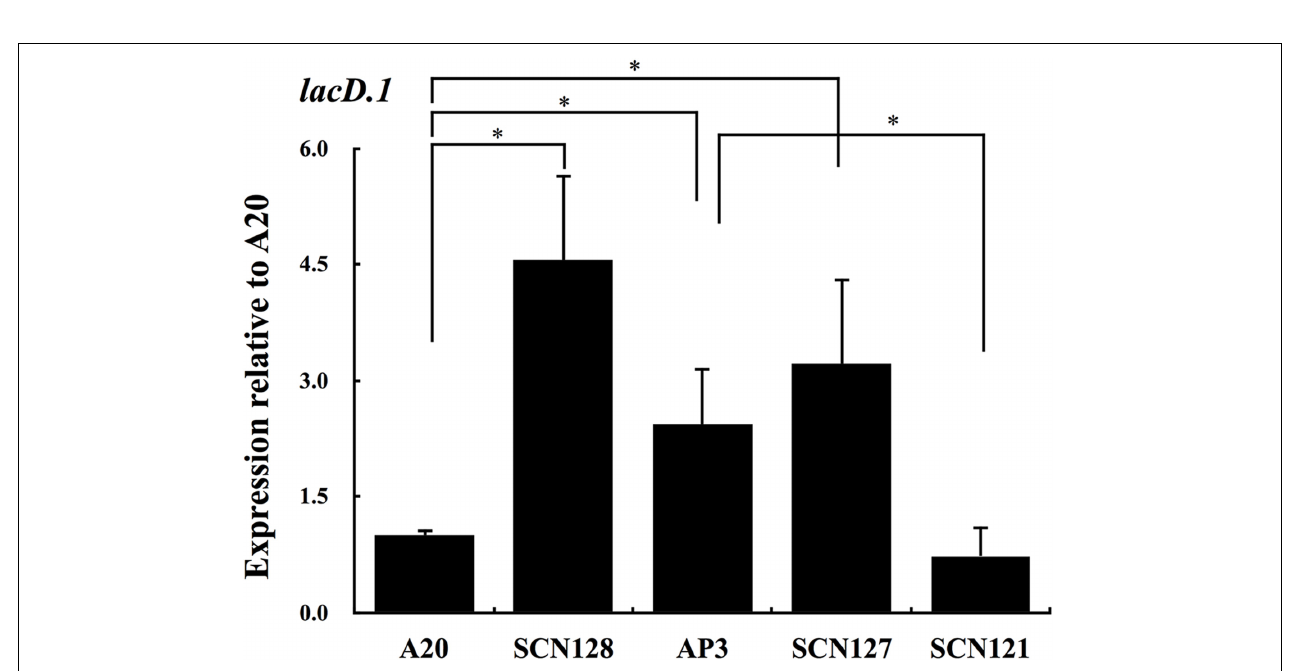
FIGURE 5 | The expression of lacD.1 in wild type A20 strain, A20 CovR D53A mutation strain SCN128, covS mutant AP3, covR/S- complemented strain SCN121, and vector control strain SCN127. The expression of lacD.1 in A20, SCN128, AP3, SCN127, and SCN121 in the stationary phase of growth. All qPCR analyses were performed using three independent RNA preparations in duplicate. Expression of the lacD.1 was normalized to the gyrA . ∗ p < 0.05.